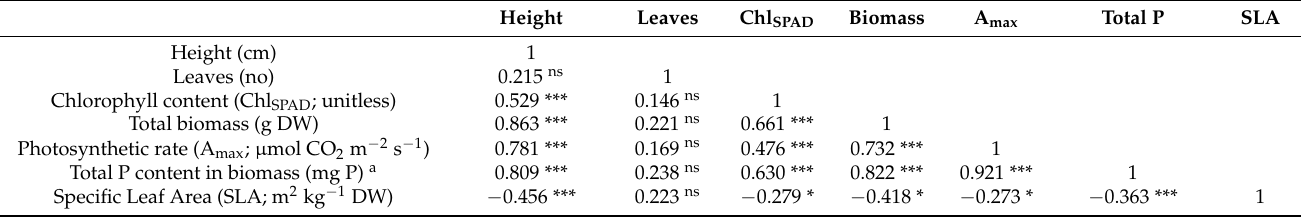
Table 4. Multivariate correlation analysis. Analysis performed for all 12 treatments for selected parameters (plant height, number of leaves, chlorophyll content, total biomass, total P content in biomass, A max , and SLA)) showing R-values. Height Leaves Chl SPAD Biomass A max Total P SLA Height (cm) 1 Leaves